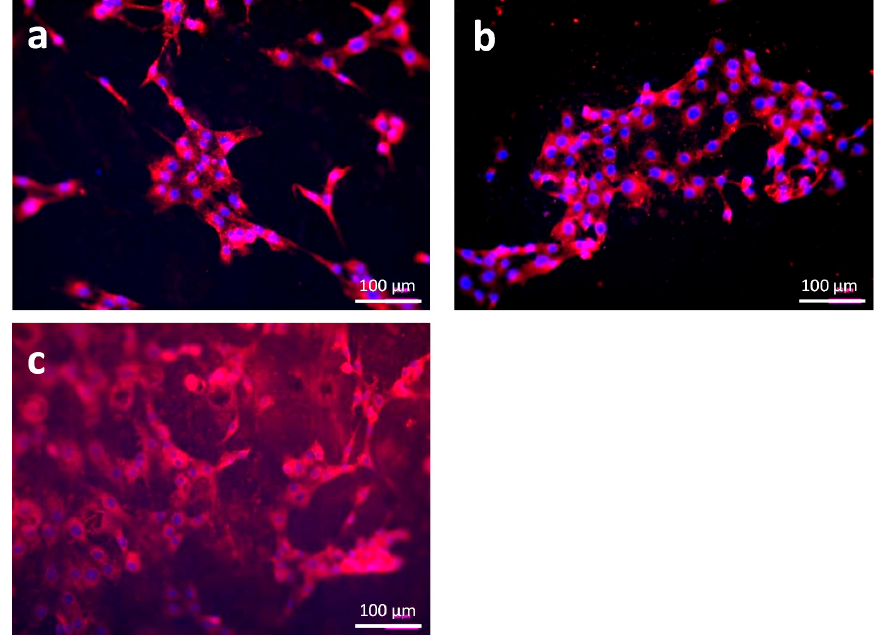
Figure 4. Fluorescence microscope image of PCL and PCL-PEG plates seeded with ST2 cells showing cytoplasm (red) and cell nuclei (blue) after two days of incubation: ( a ) PCL; ( b ) PCL-PEG 8020; and ( c ) PCL-PEG 7030.